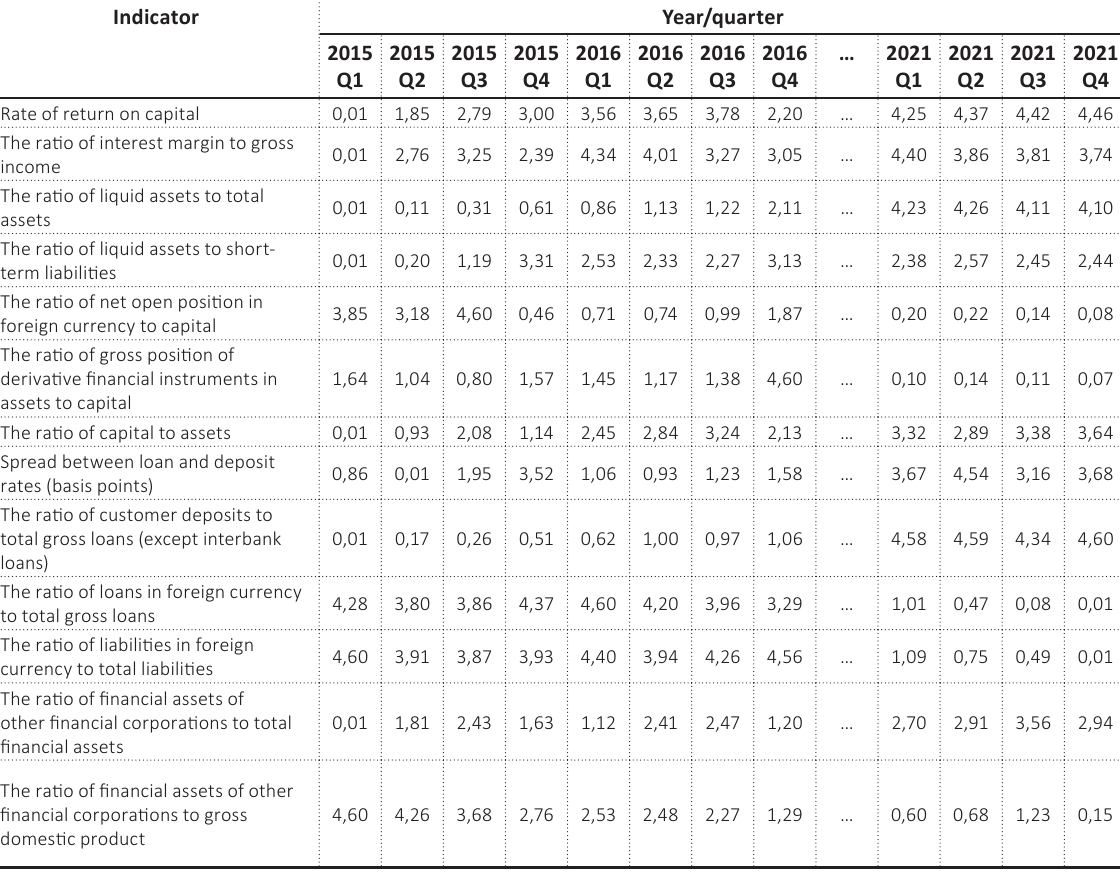
Table А3. Information base for the study of budgetary security in Ukraine Indicator